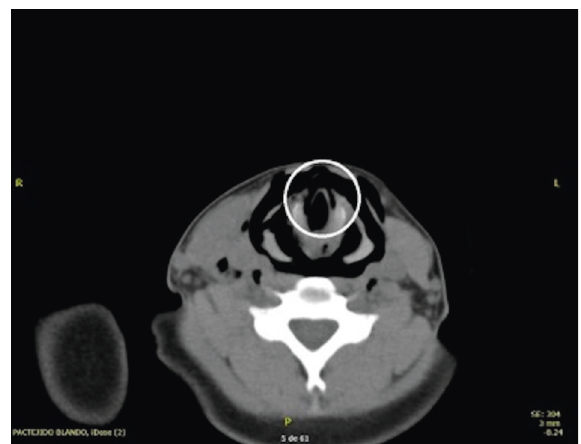
Figure 2: A 2mm continuity solution of the anterior infraglottic airway is observed.